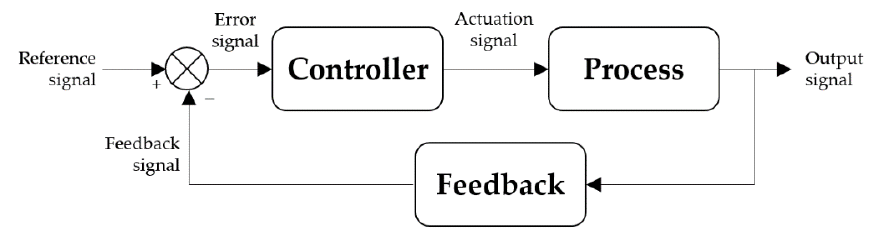
Figure 7. General block diagram of a control system.